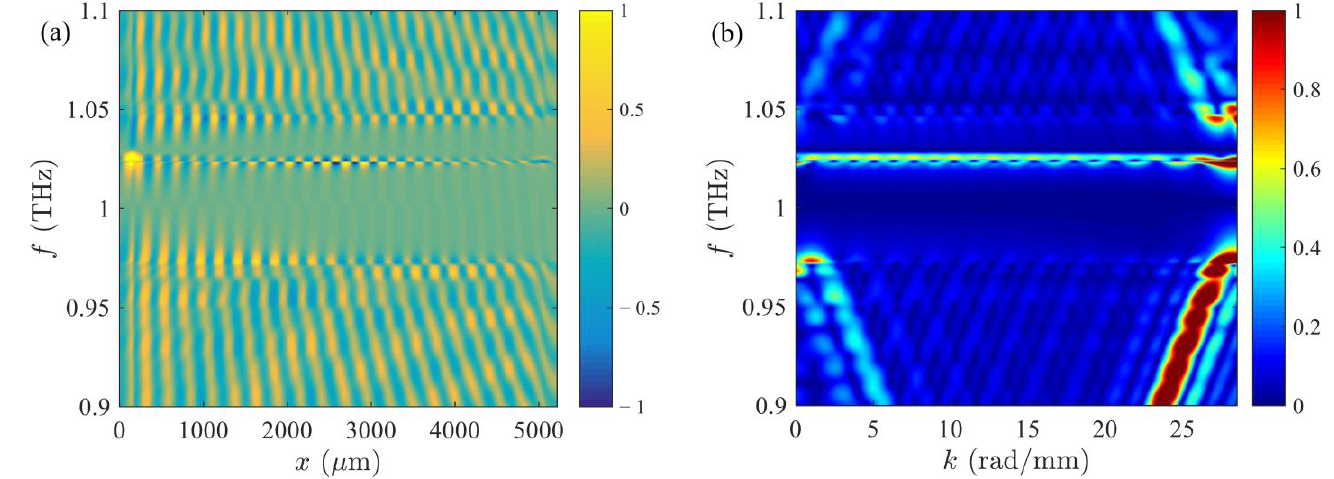
Figure 3. ( a ) Spectra along the x -axis for the waveguide with the defect; ( b ) dispersion curves depicting a defect mode between 1 THz and 1.05 THz.